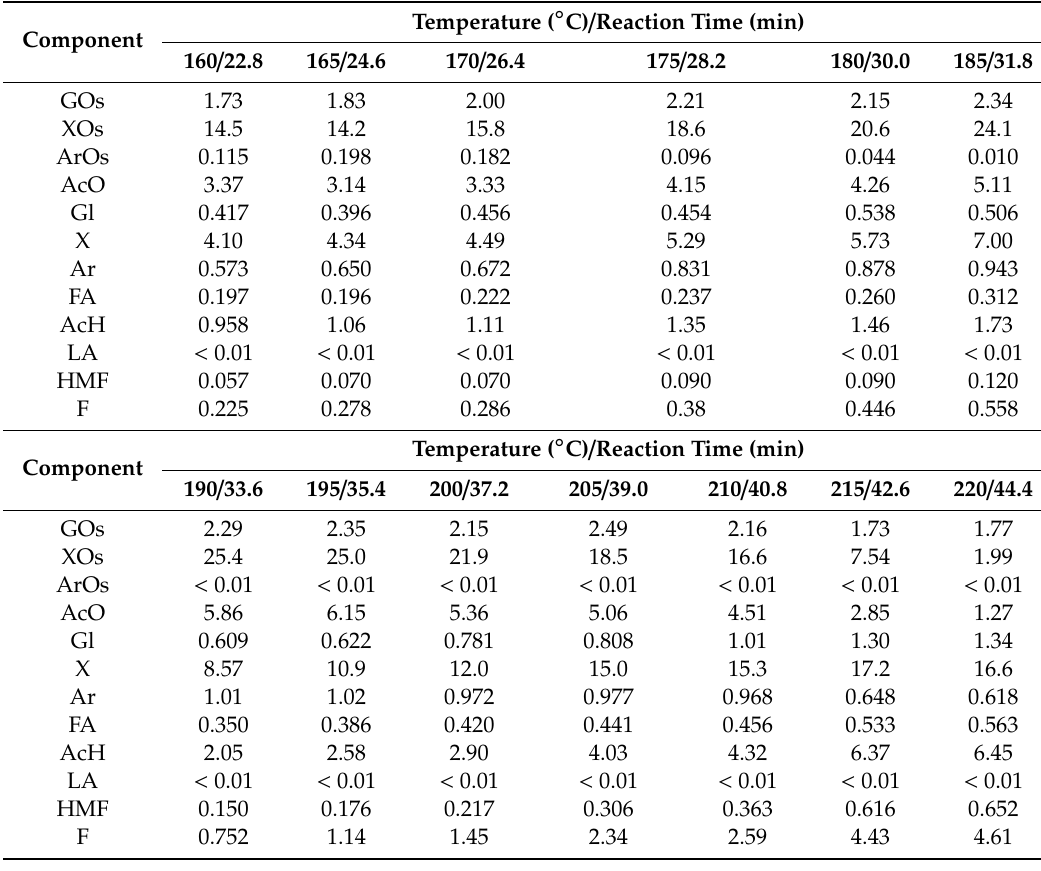
Table 3. Concentrations determined for the target products (in g / L) in the liquid phase from the second reaction